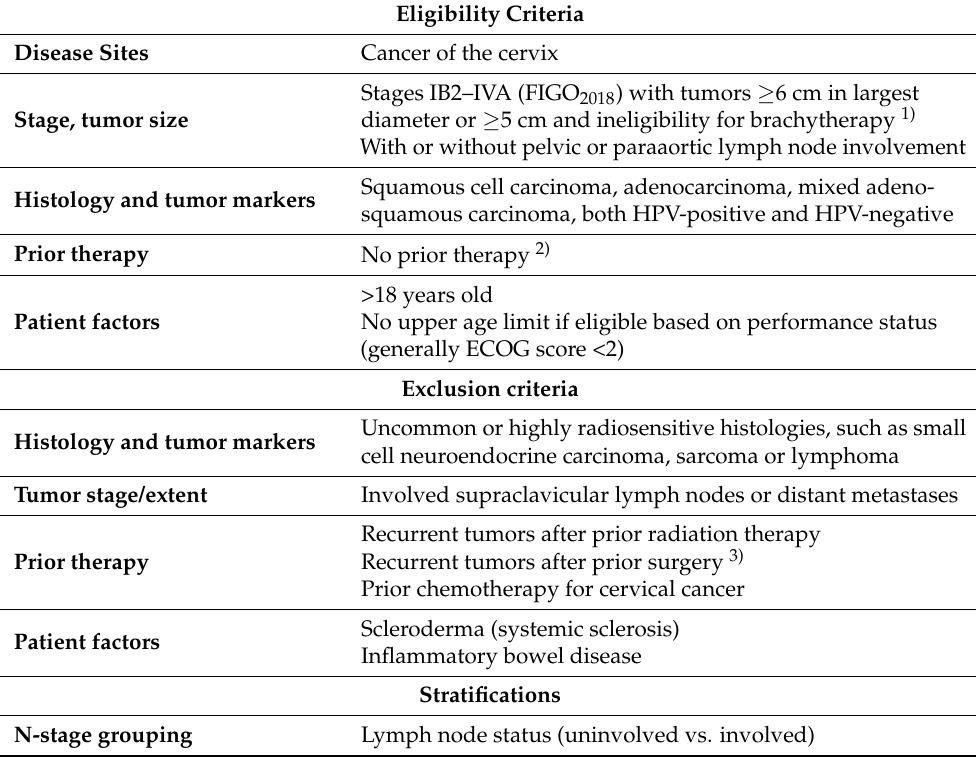
Table 3. Eligibility, exclusions, and